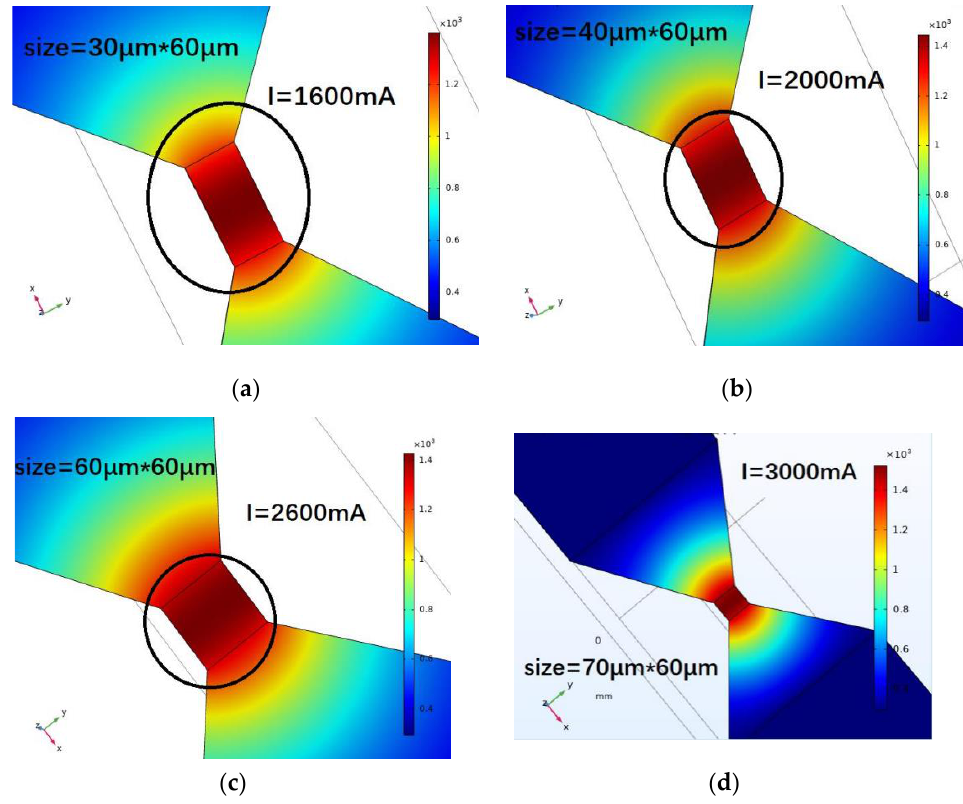
Figure 7. Multi-physical field simulation results of solid-state ON – OFF switch diversion layer in single bridge area. I = 1600 ( a ); 2000 ( b ); 2600 ( c ); 3000 ( d ) mA